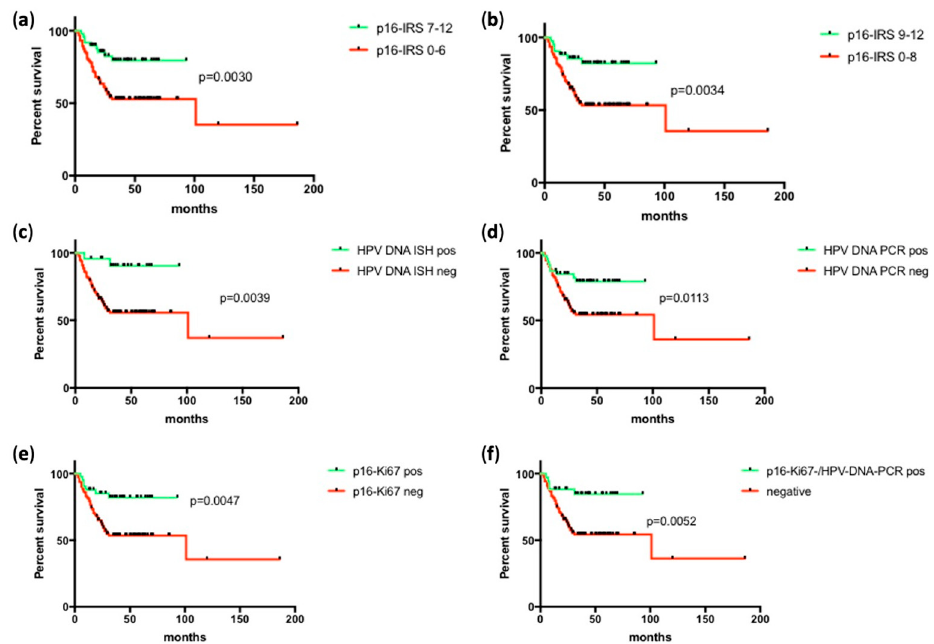
Figure 2. Overall survival of OPSCC patients depending on the detection of HPV-DNA by PCR or ISH and p16 expression. ( a ) p16 positive (green, IRS 7-12) vs. negative (red, IRS 0-6) patients; ( b ) patients grouped to p16-IRS 9-12 (high, green) and p16-IRS 0-8 (low, red); ( c ) HPV-DNA-ISH positive (green) vs. negative (red) patients; ( d ) HPV-DNA-PCR positive (green) vs. negative (red) patients; ( e ) p16-Ki67 dual positive (green) vs. negative (red) patients; ( f ) p16-Ki67 dual positive and HPV-DNA-PCR positive (green) vs. patients negative for p16-Ki67 dual staining and/or HPV-DNA- PCR (red). In ( a )–( f ), censored data are marked with a black dot. p -values are indicated for each graph (log-rank test). IRS—immunoreactive score.